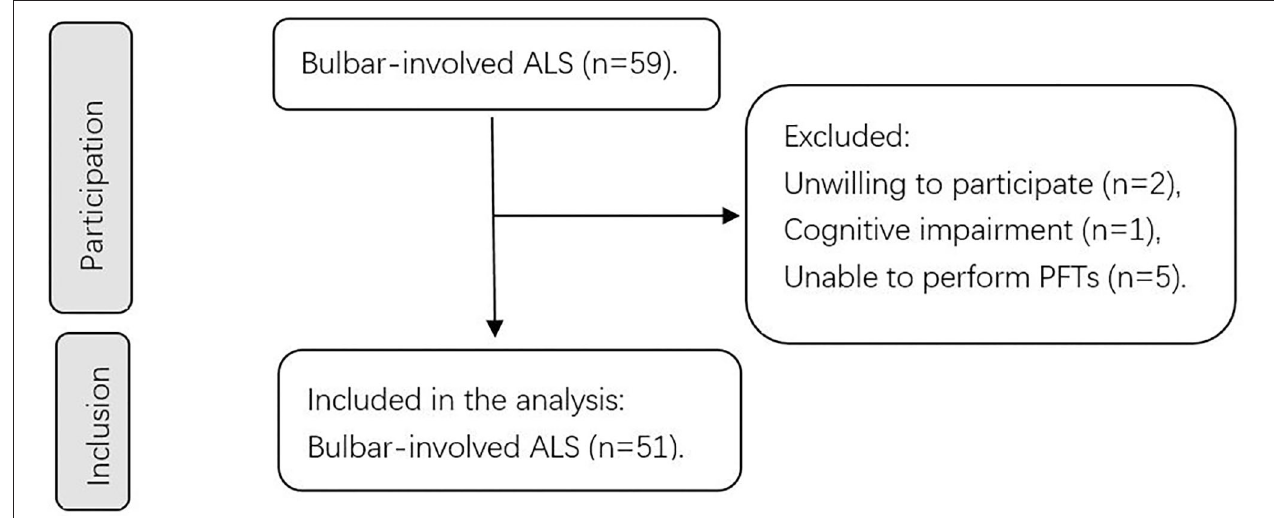
FIGURE 1 | Flowchart of our study. A schematic summarizing the number of patients during participation and inclusion. ALS, amyotrophic lateral sclerosis; PFTs, pulmonary function